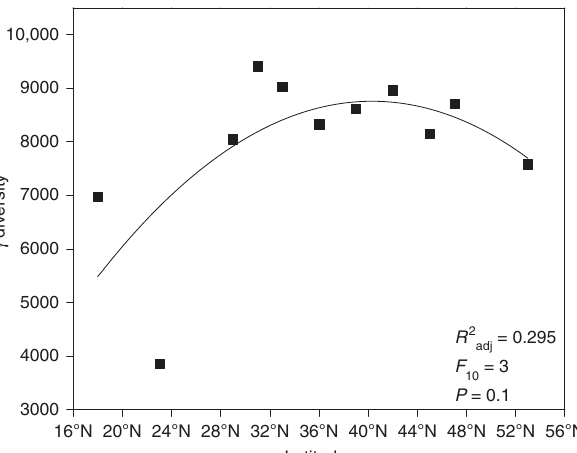
Fig. 3 Soil bacterial diversity patterns along the latitudinal gradient. a α diversity. b β diversity. c γ diversity. The relations between ( α , β , and γ ) diversity and latitude were evaluated using linear and polynomial regressions and the best polynomial fi t was determined on the basis of Akaike information criterion (AIC) and the corrected Akaike information criterion AIC (AICc). The P -values by two-sided F -test are indicated in a – c ( n = 60 independent samples). The source data are provided as a Source data fi